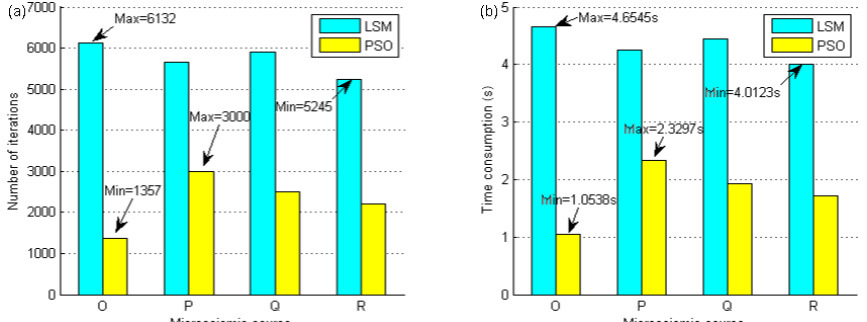
Figure 4. (a) Comparison of the number of iterations between the LSM and PSO algorithms, where the max and min markers highlight the maximum and minimum number of iterations for each algorithm. (b) Comparison of the computing time between the LSM and PSO algorithms, where the max and min markers highlight the maximum and minimum amount of computing time for each